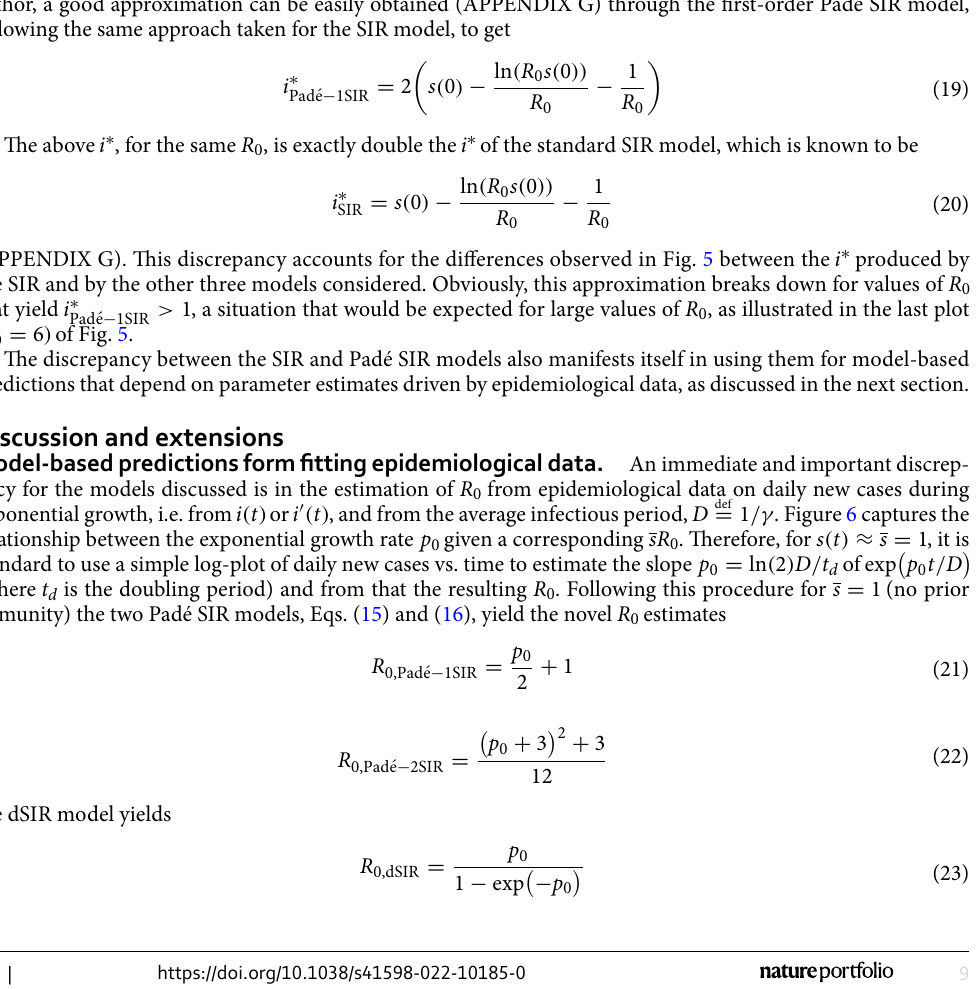
1 for an epidemic with no prior ln ( 2 ) D / t d and that s = =